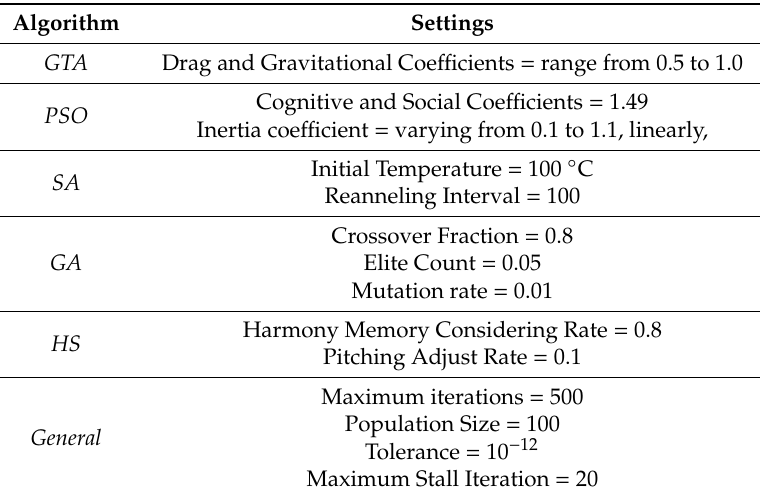
Table 1. Optimization algorithms’ settings.